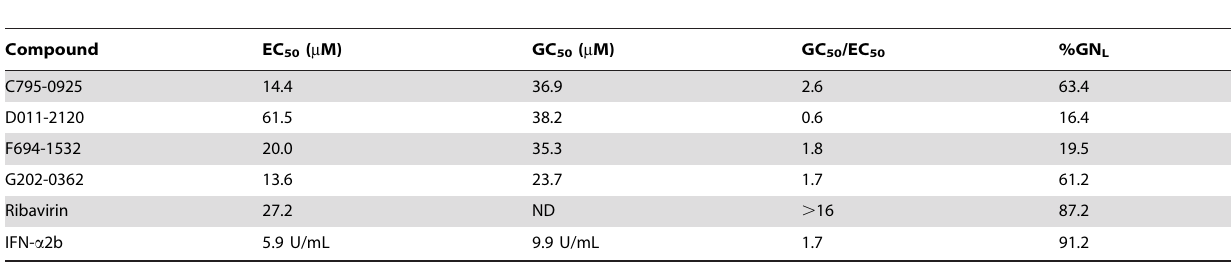
Table 3. Golgi disruption properties of the four hit compounds and reference compounds derived from HCI-based analysis of HeLa-G cells.